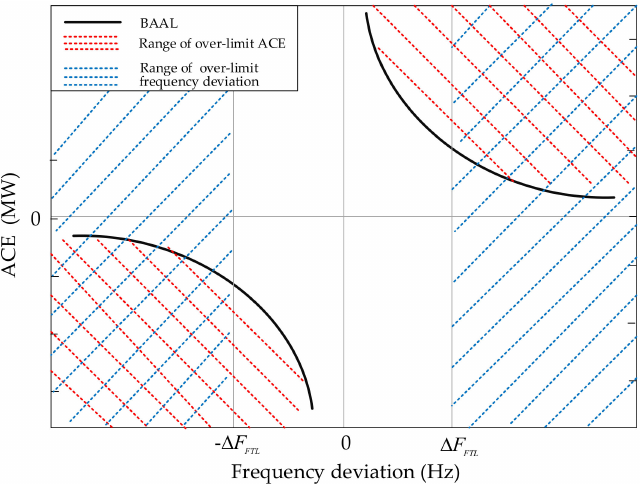
Figure 1. Requirement for Area Control Error (ACE) in the BAAL